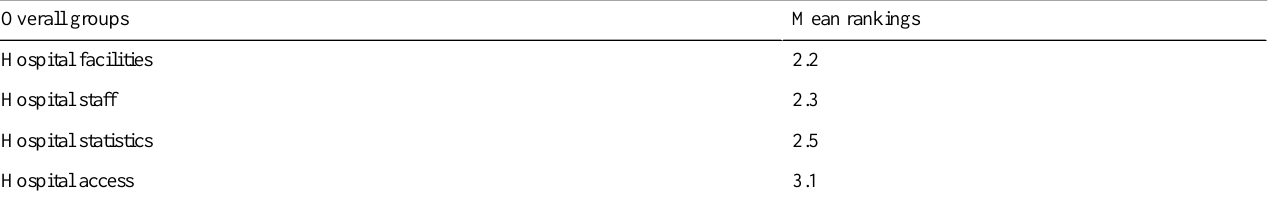
Table 2. Mean rankings between